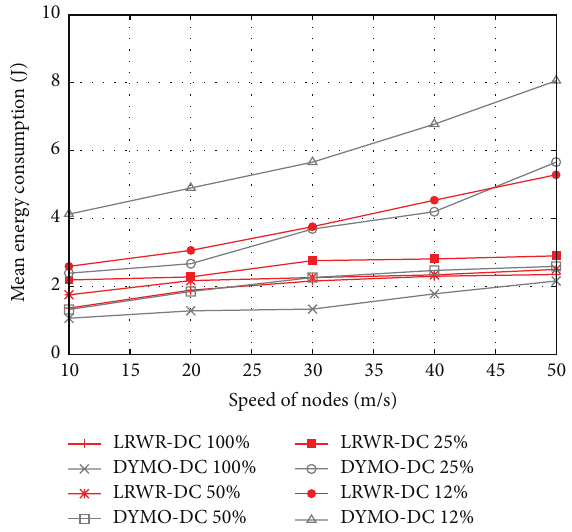
Figure 10: Mean energy consumed versus speed of nodes.